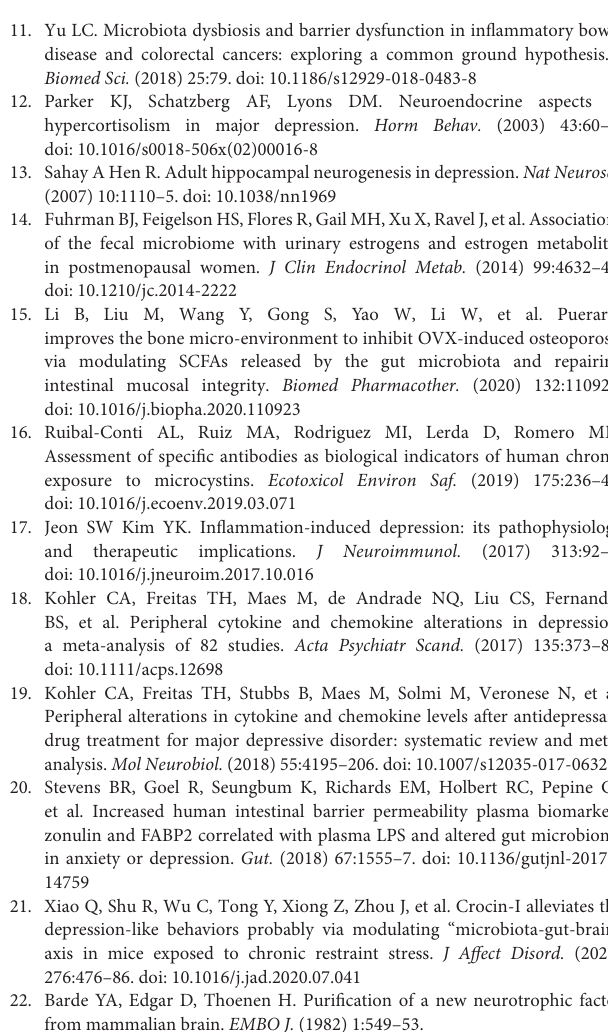
Supplemental Figure 2 | P. histicola significantly increased the total distance and mean speed of OVX mice in OFT (A,B) . (A) Total distance and (B) mean speed of OVX mice in OFT. ns p > 0.05, ∗ p < 0.05. Supplemental Figure 3 | OVX and P. histicola did not influence intestinal bacterial diversity (A,B) . (A) Alpha diversity index ACE and (B) Chao. ns p > 0.05. Supplemental Figure 4 | OVX and P. histicola did not destroy intestinal mucosa (A,E,H) . Magnification 200 × and 400 × . Scale bar = 20 µ m. Supplemental Figure 5 | OVX and P. histicola did not regulate the level of hippocampal IL-17a. (A) The mRNA expression of hippocampal IL-17a. ns p >